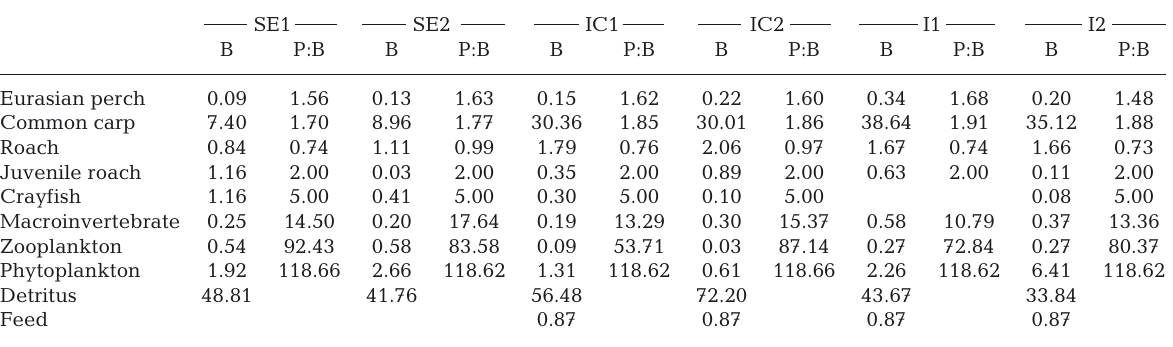
Table 3. Estimated average biomass (B, g m –2 ) and production:biomass ratios (P:B) for a 280 d rearing period of the trophic groups in replicates 1 and 2 of the semi-extensive (SE), intensive-coupled (IC) and intensive (I) ponds, based on experimental observations